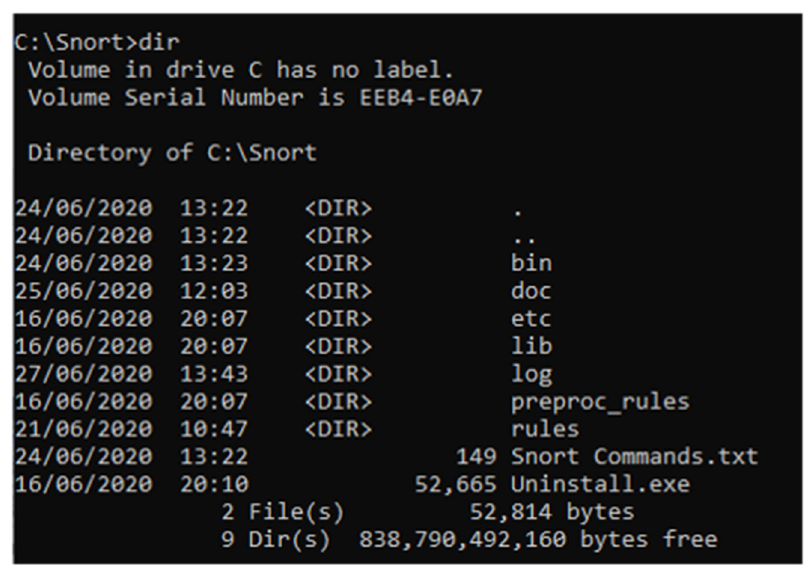
Figure 12. Location of SNORT folders extracted from SNORT website [44].